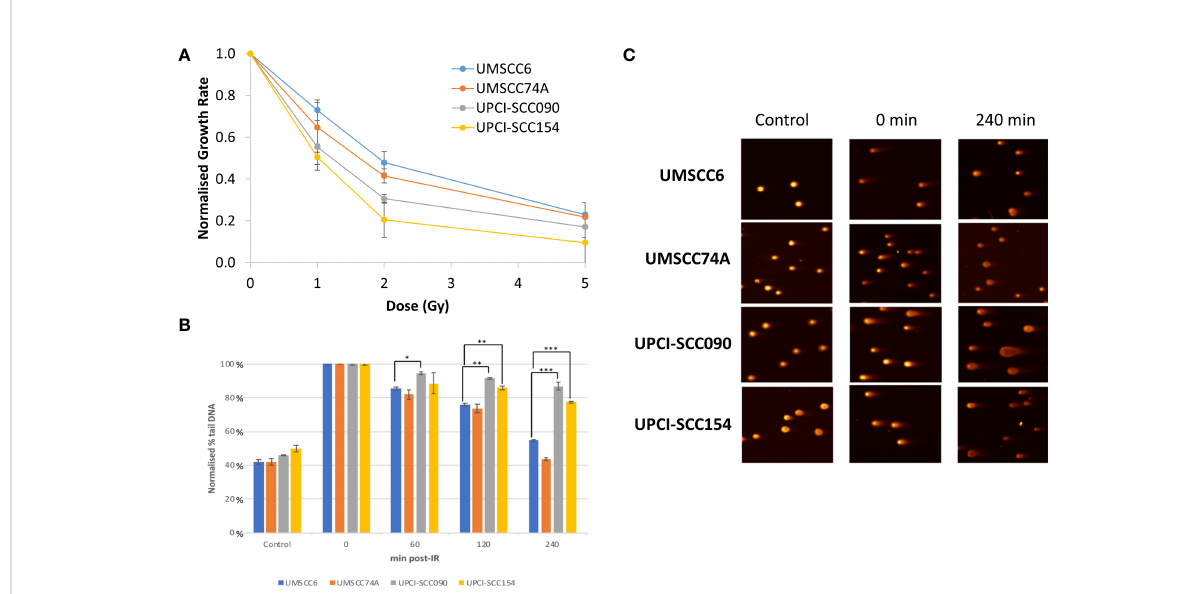
FIGURE 1 Analysis of the ef fi ciency of repair of IR-induced DSBs in HPV-positive and HPV-negative OPSCC spheroids. (A) Spheroids were allowed to develop for 48 h in ultra-low attachment plates and then unirradiated or irradiated (1, 2, or 5 Gy) on day 3 with a single dose of x-rays. The rate in growth of HPV-negative OPSCC spheroids (UMSCC6 and UMSCC74A) and HPV-positive OPSCC spheroids (UPCI-SCC090 and UPCI- SCC154) measured by microscopy from day 3 to day 12 was calculated following each dose of radiation and normalised against the unirradiated controls (set to 1.0). Data were analysed from three biologically independent experiments. (B, C) Spheroids were allowed to develop for 48 h in ultra-low attachment plates and then unirradiated or irradiated (5 Gy) with a single dose of x-rays. Spheroids were harvested at the relevant time points post-irradiation (0-240 min), trypsinised into single cells and DSB levels measured using the neutral comet assay. (B) Shown is the mean % tail DNA with standard deviations from three independent biological experiments, normalised to the DNA DSBs levels at 0 min post-IR, which was set to 100%. *p < 0.02, **p < 0.01, ***p < 0.005 as analysed by a one sample t-test. (C) Representative images of comets derived from OPSCC spheroids acquired from unirradiated controls and immediately or 240 min